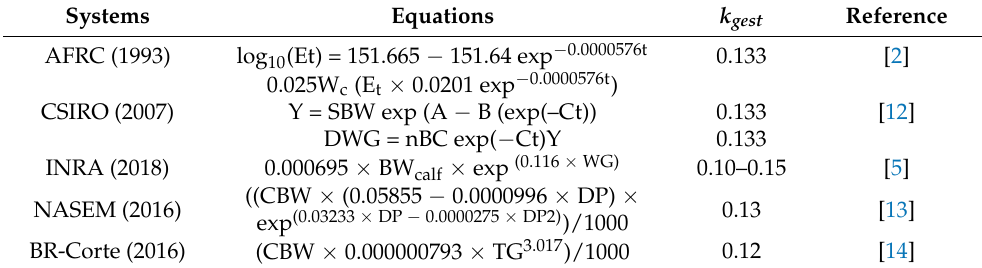
Table A5. Equations used to calculate pregnancy requirements in suckler cows (NE gest )